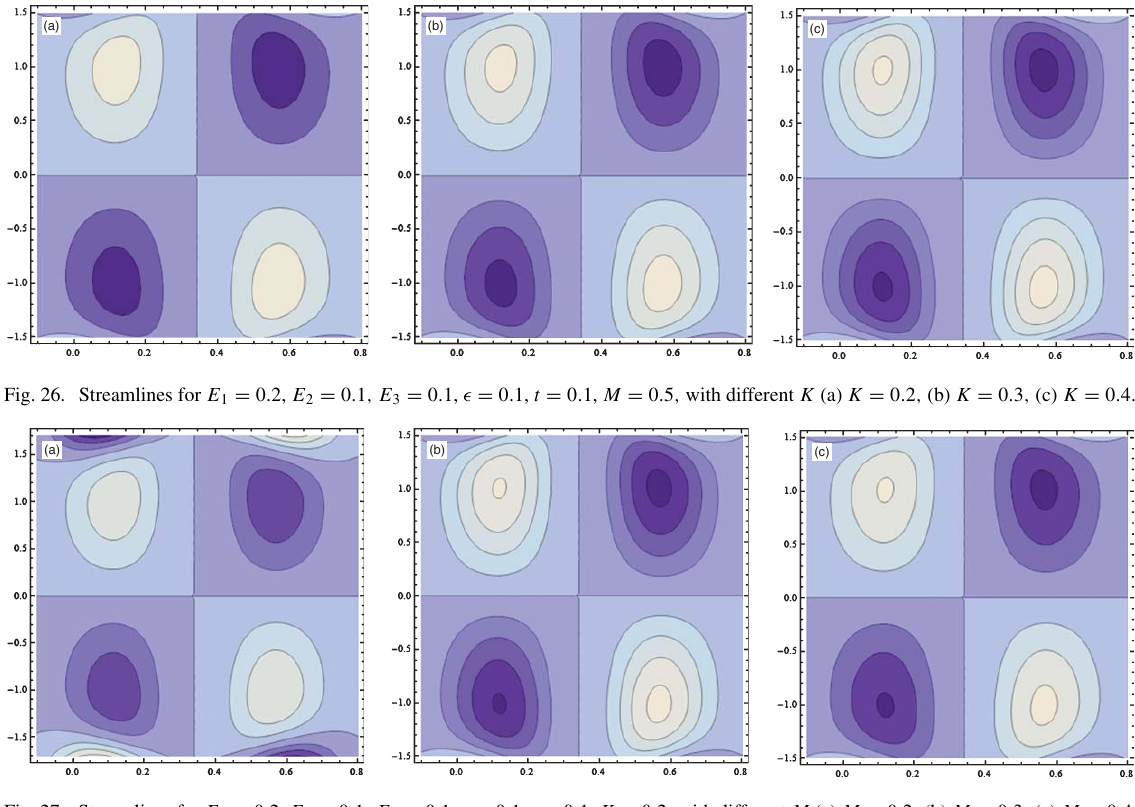
Fig. 27. Streamlines for E 1 = 0 . 2, E 2 = 0 . 1 , E 3 = 0 . 1, (cid:15) = 0 . 1, t = 0 . 1, K = 0 . 2 , with different M (a) M = 0 . 2 , (b) M = 0 . 3 , (c) M = 0 . 4